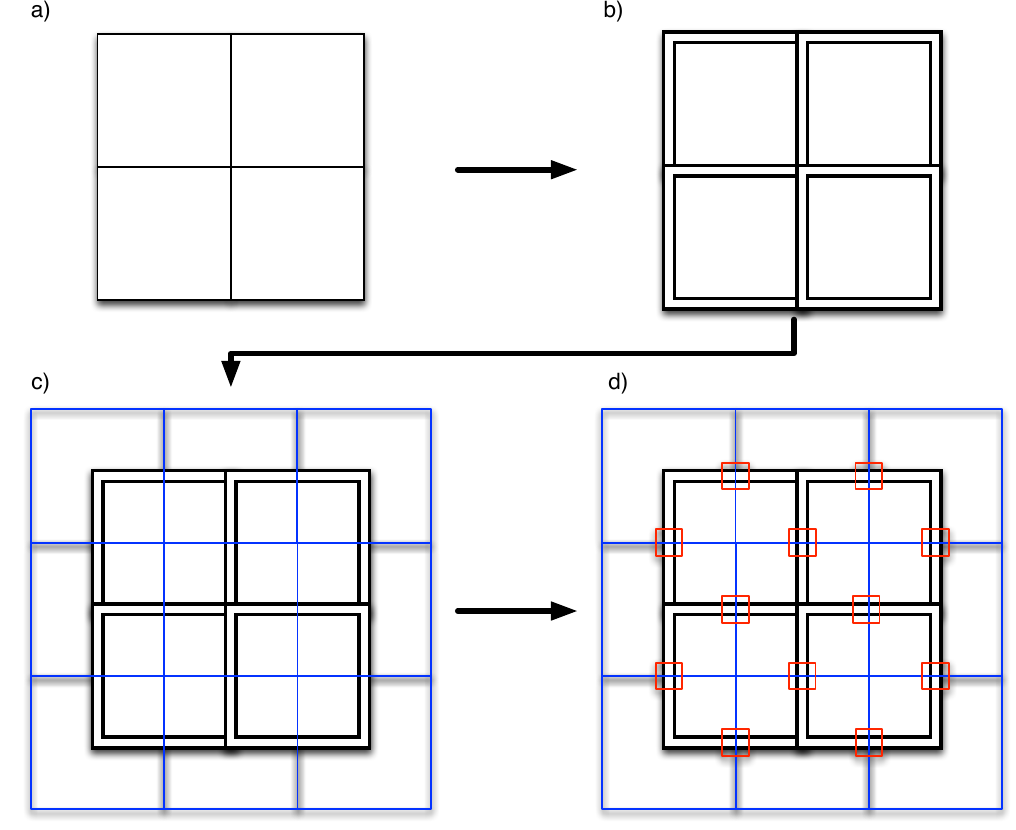
Figure 8. To segment large area datasets, processing was undertaken in three steps: ( a ) tiling and segmentation of the tiles; ( b ) Identification of boundary objects in the segmented tiles; ( c ) generating a mask defining regions of boundary objects, retiling with half a tile offset and re-segmentation of the masked regions; ( d ) finally, the remaining isolated boundary regions within the red squares are identified and individually